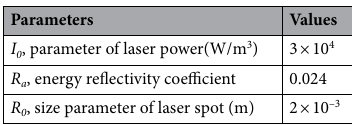
Table 1. Parameters of laser beam.